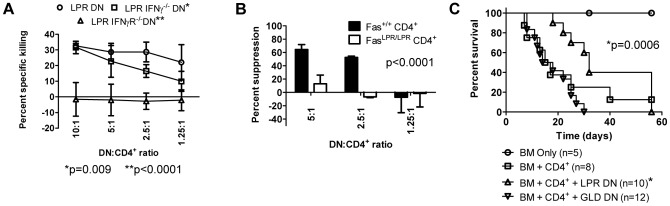
IFNγ secretion and signalling and FasL expression enable B6.lpr DN T cells to inhibit alloreactive CD4+ T cells in vitro and in vivo.
A. Preactivated 3H-thymidine labelled CD4+ T cells were cultured for 18h with preactivated B6.lpr, B6.lpr.IFNγ−/−, or B6.lpr.IFNγR−/− DN T cells at indicated ratios. Specific cytotoxicty was determined based on retention of 3H-thymidine in viable targets. Data are compiled from 4 experiments in which, respectively, B6.lpr (circles), B6.lpr. IFNγ−/− (squares), or B6.lpr.IFNγR−/− (triangles) DN T cells were used in 4, 3, and 2 experiments. Compared with B6.lpr DN, *Two-way ANOVA p = 0.0009 and **p<0.0001. B. In varying ratios, B6.lpr DN T cells were cultured with CFSE-labelled B6. Thy1.1 (Fas+/+) or B6.lpr (Faslpr/lpr) CD4+ T cells, irradiated CB6F1 splenocytes and IL-2. CFSE dilution in live (7-AAD−) cells was determined after 5 days. Data from 2 independent experiments are shown; two-way ANOVA p<0.0001. C. Lethally irradiated CB6F1 mice received BM only (n = 5), BM+CD4+ (n = 8), BM+CD4++2.5×106 B6.lpr DN (n = 10, FasL+) or 2.5×106 B6.gld DN (n = 12, FasL−). Data are from 2 independent experiments, each with 2–6 mice per group. *Log rank p = 0.006 vs. B6.gld DN.